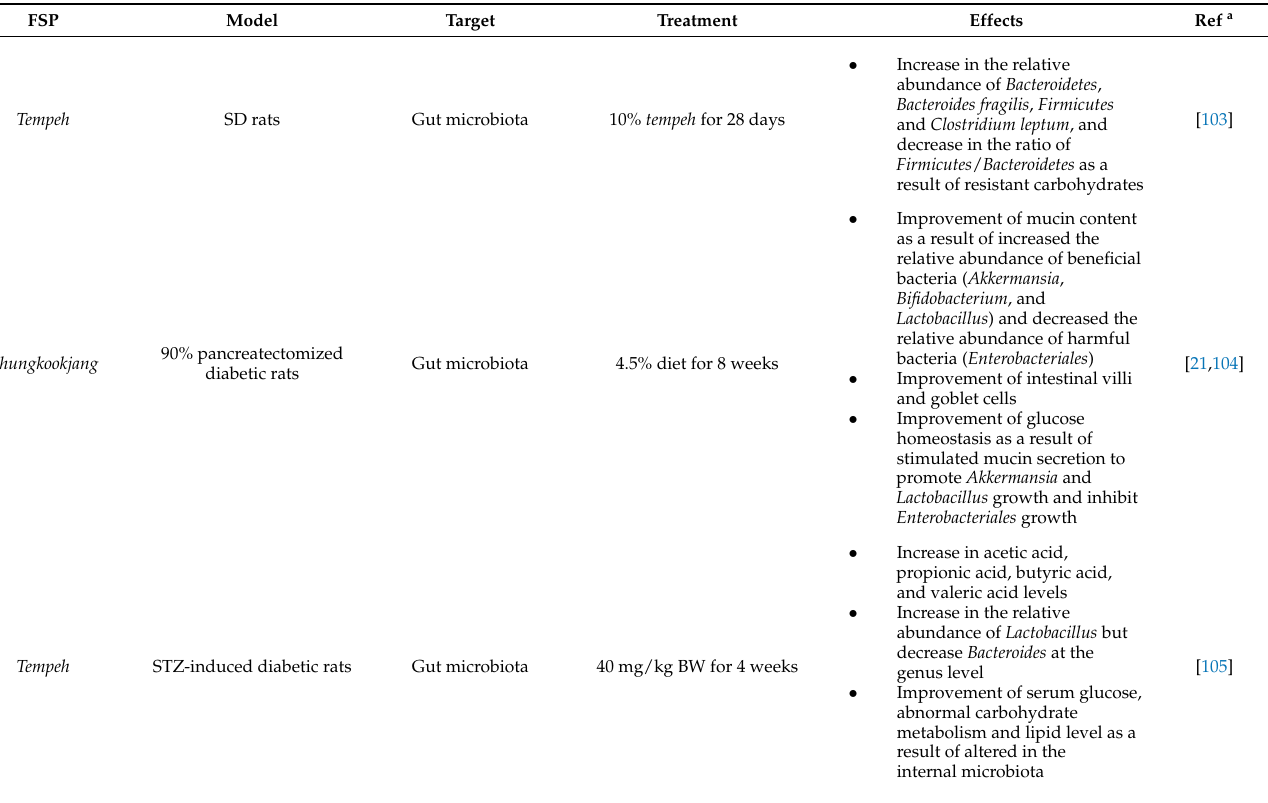
Table 7. The mechanisms of modulating effect of FSP on glucose homeostasis through gut